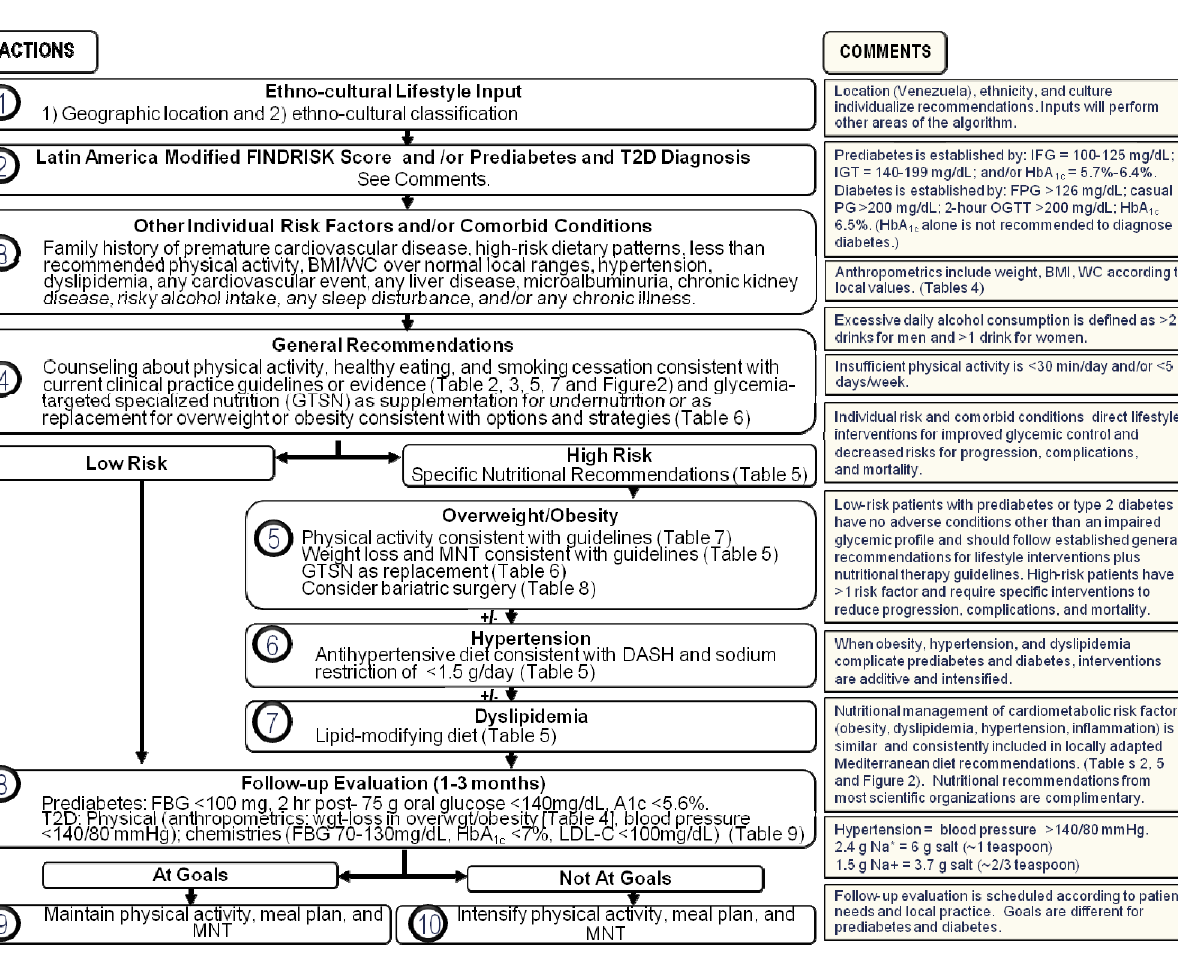
Figure 1. Transcultural diabetes nutrition algorithm for prediabetes and type 2 diabetes—Venezuelan